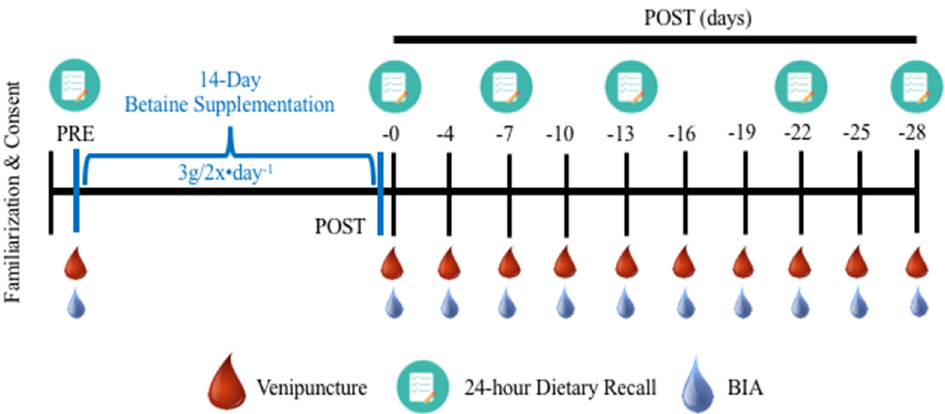
Figure 1. Visualization of investigation methodology and general timeline. BIA = bioelectrical impedance analysis.